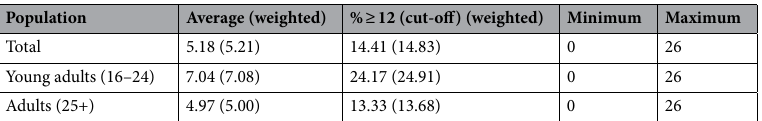
Variable N Average Minimum Maximum Population of the municipality of residence ( *